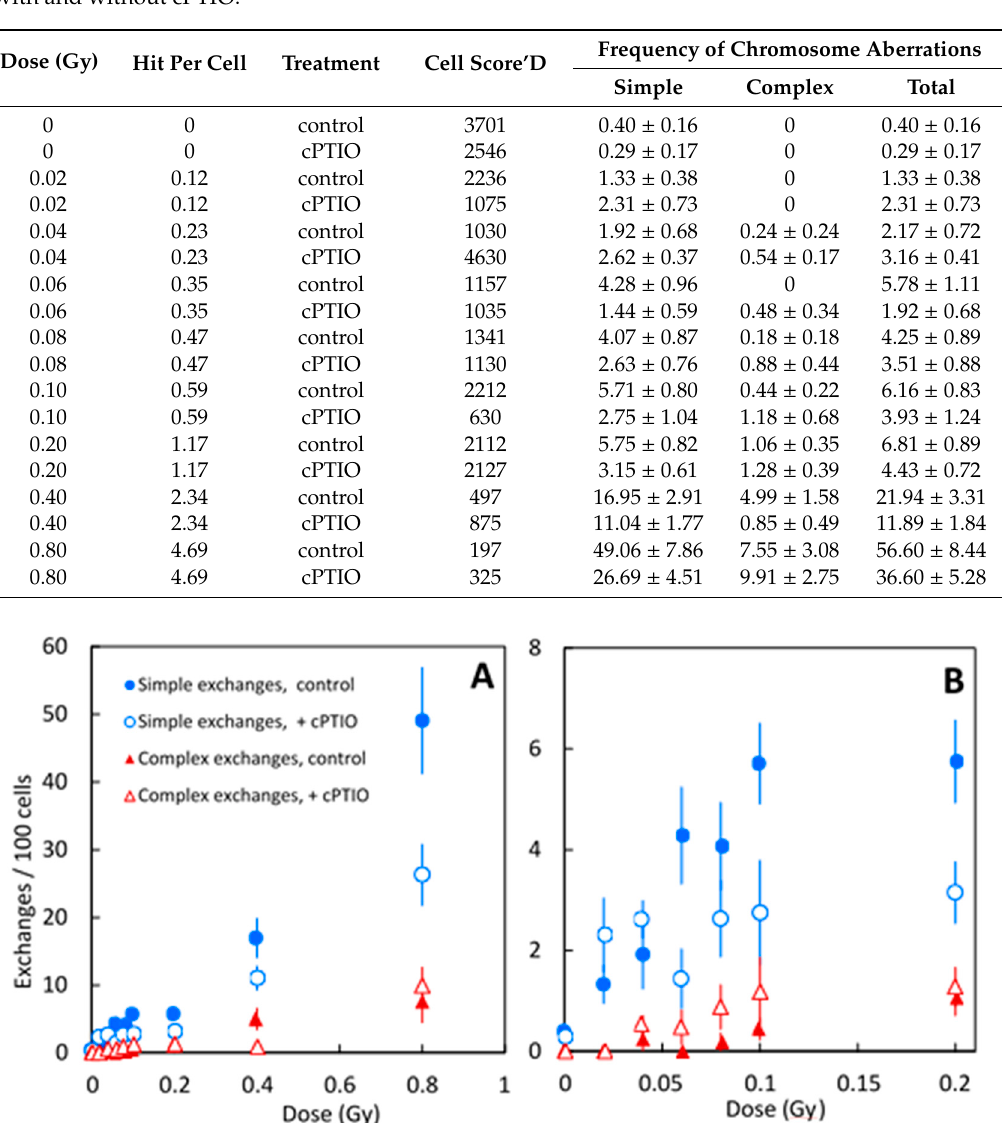
Table 2. Whole genome equivalent for frequency of CA per 100 cells exposed to Fe ions (600 MeV/u) with and without cPTIO.